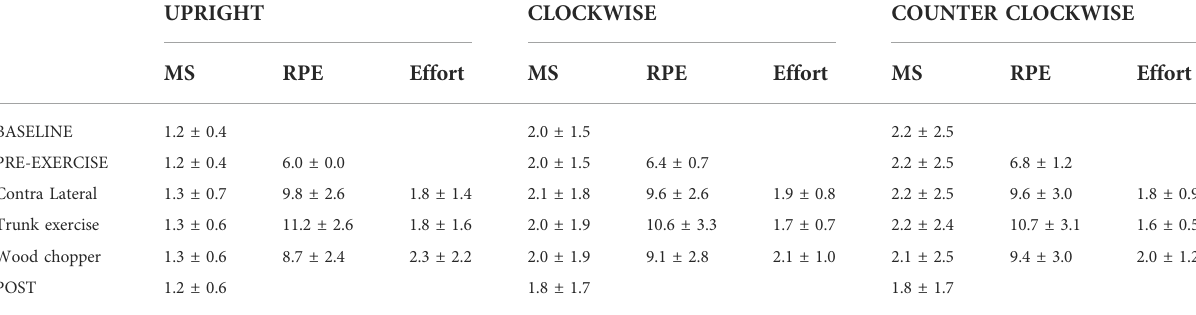
TABLE 1 Motion sickness (MS), perceived exertion (RPE) and effort ratings supine (BASELINE), prior to standing (PRE-EXERCISE) in the UPRIGHT condition, andwhen rotating passively (PRE-EXERCISE)clockwise (CLOCKWISE)and counter-clockwise (COUNTER-CLOCKWISE) with 1 gat the